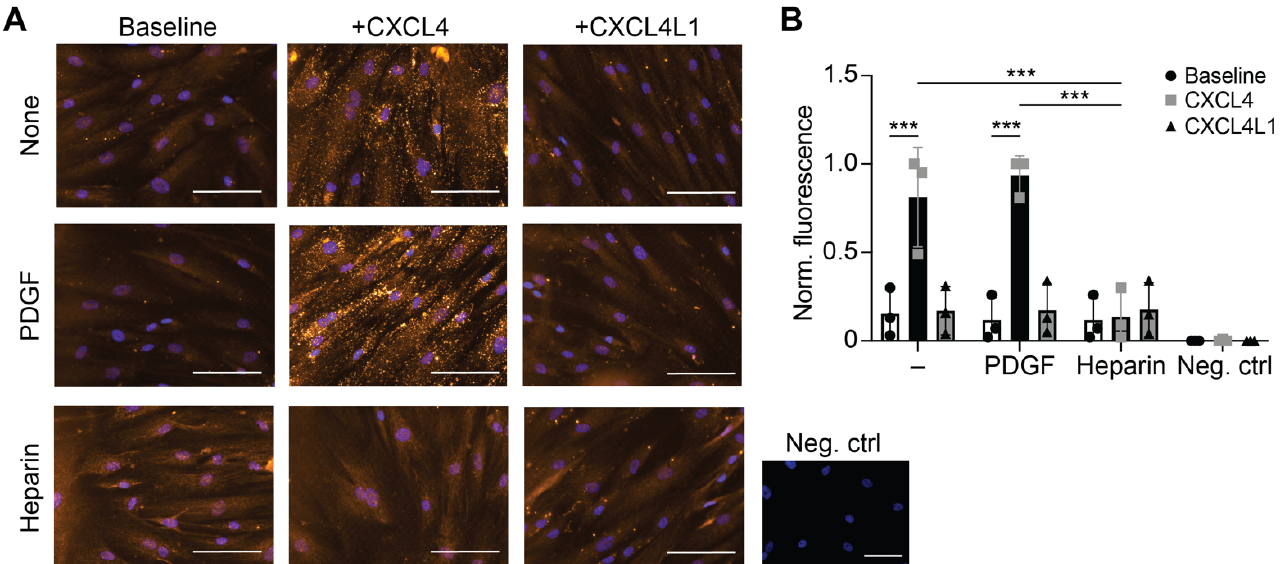
Figure 3. Influence of VSMC phenotype on chemokine uptake. Prior to the addition of CXCL4, CXCL4L1 (at 0.5 μ g/mL) or buffer, VSMC were cultured in the presence of PDGF ‐ BB (20 ng/mL, 3 days) or heparin (200 U/mL, 5 days). After incubation with chemokines for 1 h at 37 °C, cells were washed with heparin and stained for CXCL4 with permeabilization. The negative control is without anti ‐ CXCL4 antibody. ( A ) Representative micrographs showing CXCL4 staining. Scale bar: 100 μ m. ( B ) Quantification of fluorescence normalized by minimum and maximum, four images per well (three wells per experiment of three separate experiments). *** p < 0.001, n = 3, two ‐ way ANOVA with Dunnett’s post ‐ test.